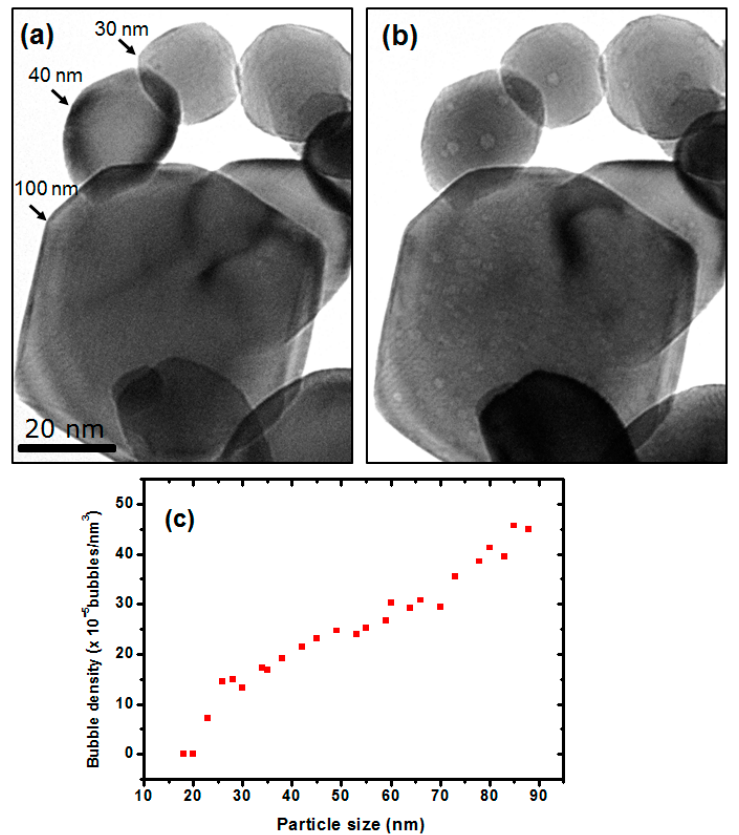
Figure 4. Underfocus BF-TEM images for W NPs: ( a ) unirradiated and ( b ) irradiated to a fluence of 1.1 × 10 17 ions · cm − 2 showing the bubble distributions in NPs of different sizes. The relationship between bubble density and particle size for W NPs with different diameters irradiated to a fluence of 1.1 × 10 17 ions · cm − 2 is shown in ( c ). (The scale marker in ( a ) applies to both